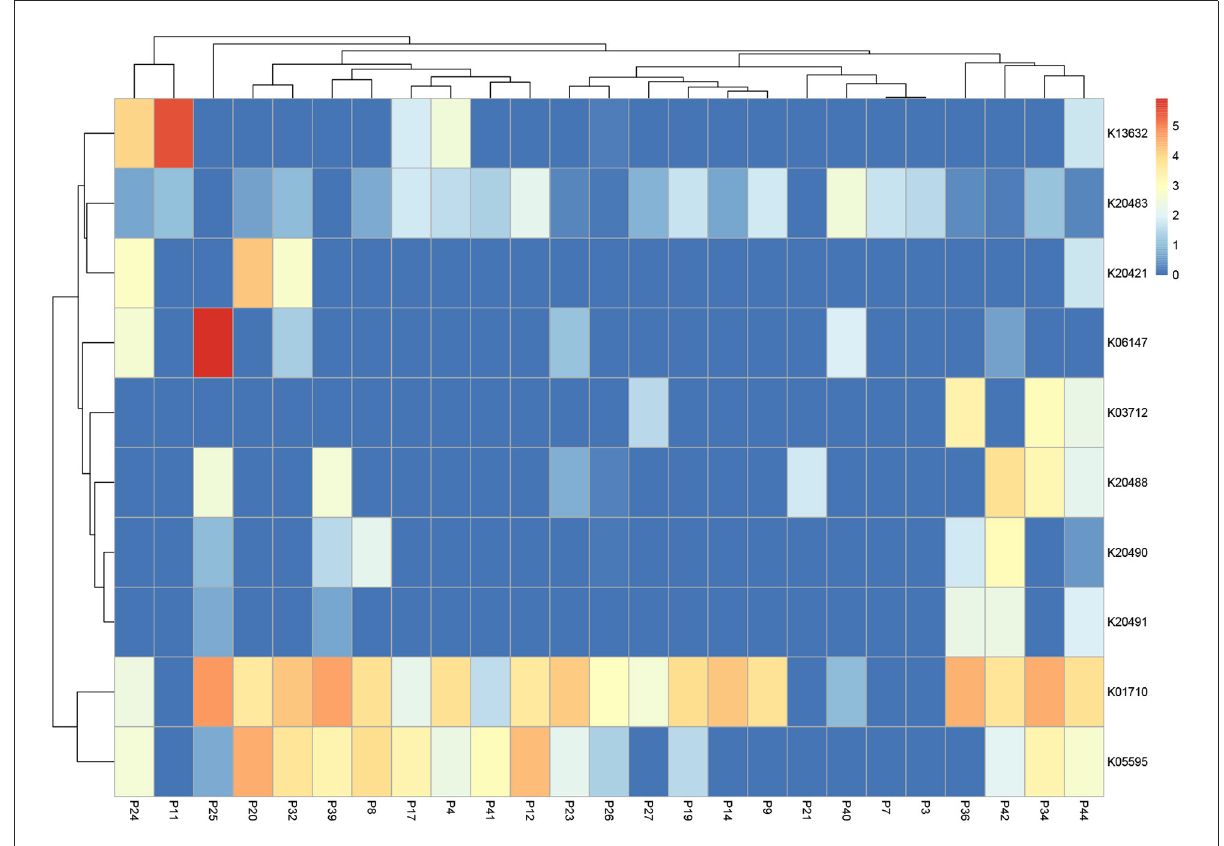
FIGURE5 Heatmap highlighting the top 10 expressed transcripts across all samples associated with “antibiotics and multi-drug resistance”. Data is normalized and displayed to LogTPM.